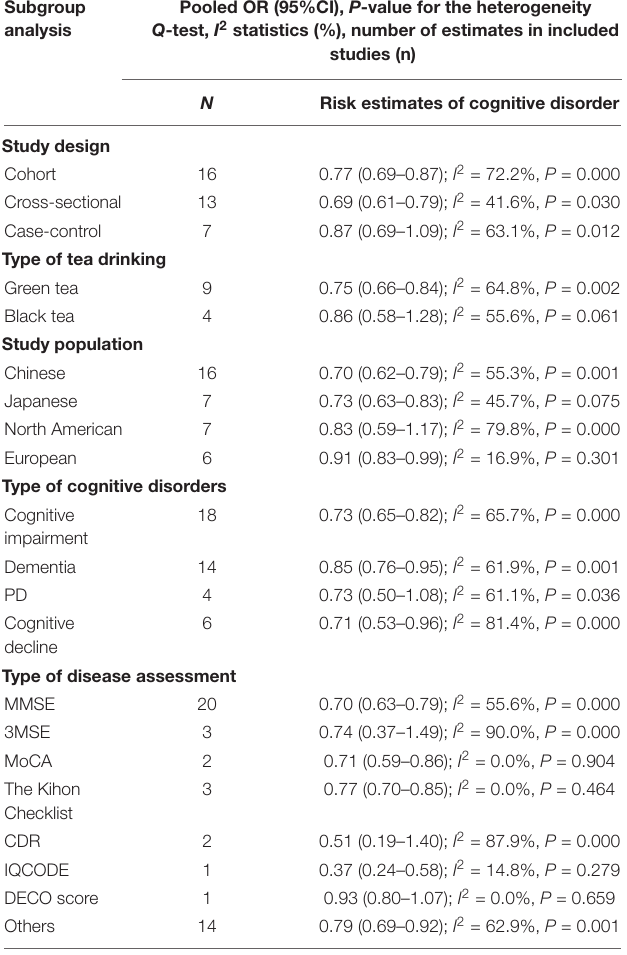
TABLE 2 | Combined results of subgroup analysis of tea drinking and cognitive function. Subgroup analysis